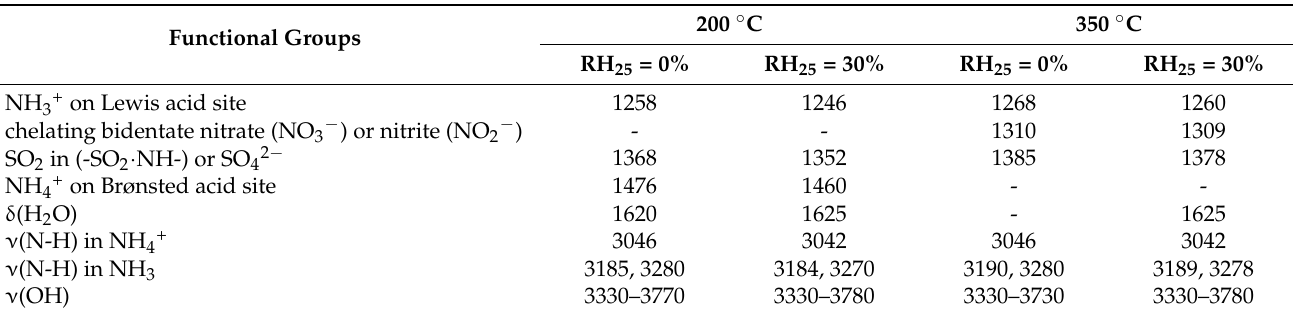
Table 2. Assignments of IR absorption bands (cm − 1 ) appeared in DRFIT spectra on the surface of 2D SnO 2 in dry (RH 25 = 0%) and in humid (RH 25 = 30%) air containing 100 ppm NH 3 at 200 ◦ C and 350 ◦